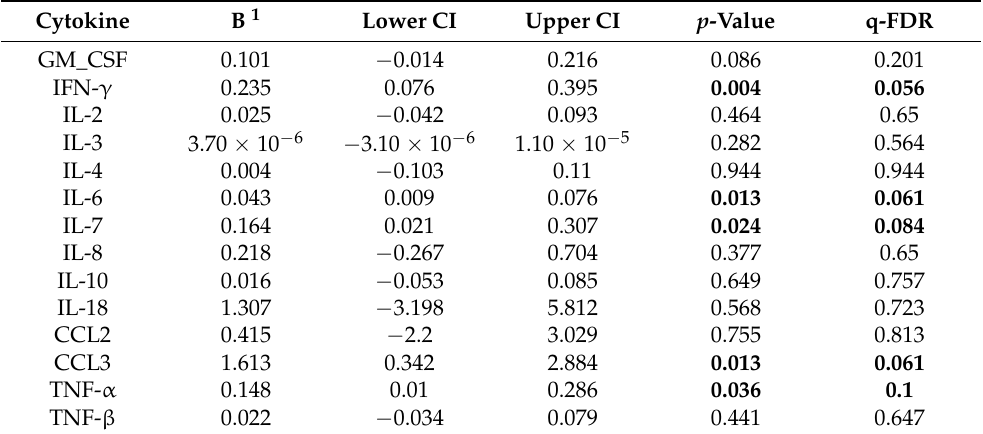
Table 2. Association of BMI with levels of inflammatory parameters. In bold statistically significant p -values and q-FDR (False Discovery Rate).